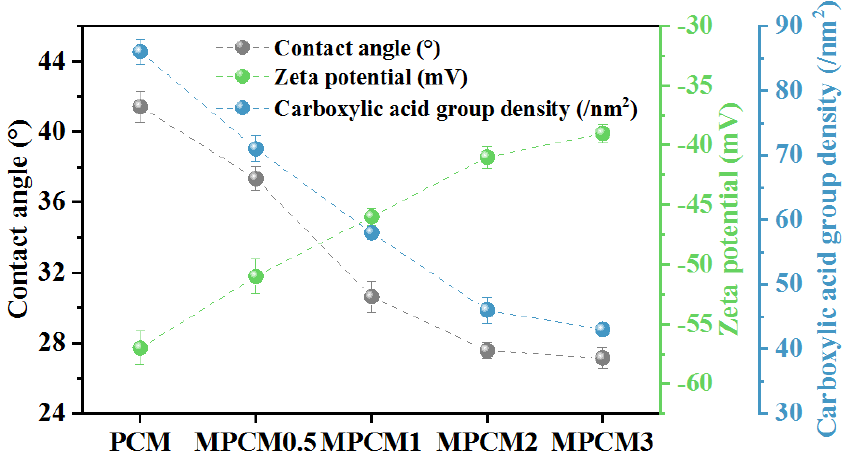
Figure 2. Physiochemical characteristics of the PCMs and